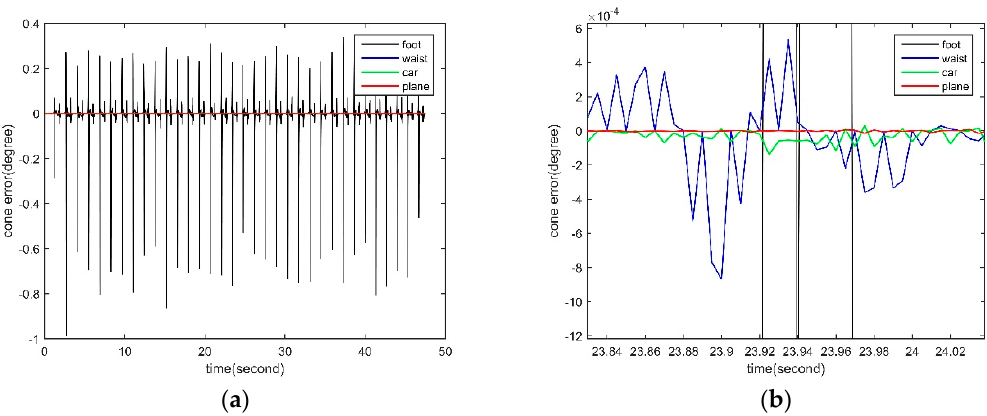
Figure A2. SINS cone error between each adjacent two sampling points. ( a ) SINS cone error between each adjacent two sampling points from four different carriers for plane, car, foot and waist; ( b ) Partial enlarged detail for ( a ).